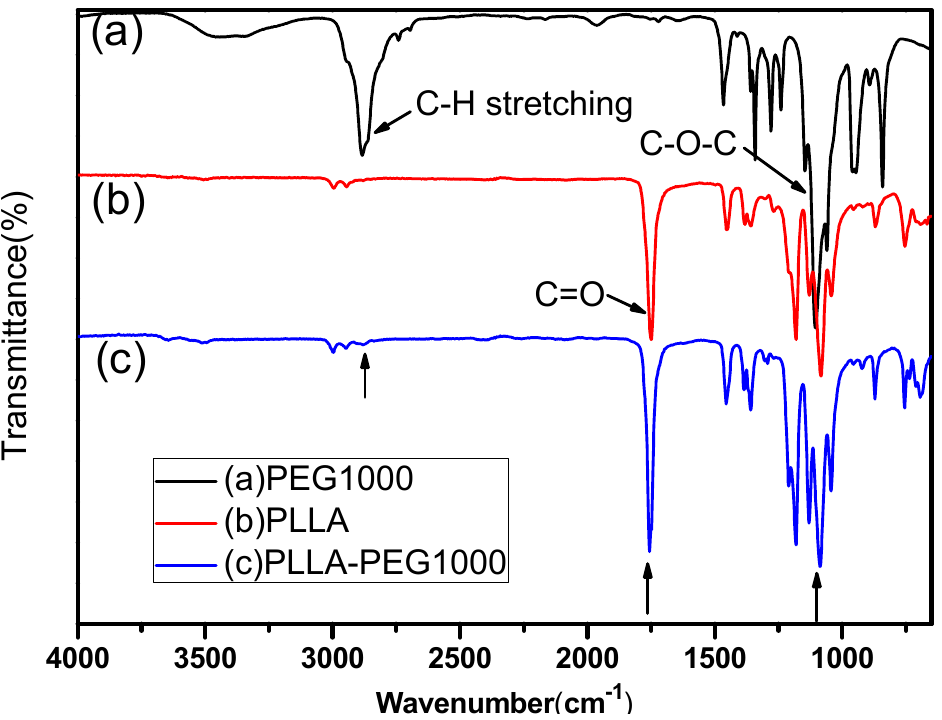
Figure 2. The FTIR spectra of PEG1000, PLLA, and PLLA-PEG1000 copolymers. ( a ) PEG1000 ( b ) PLLA ( c ) PLLA-PEG1000.